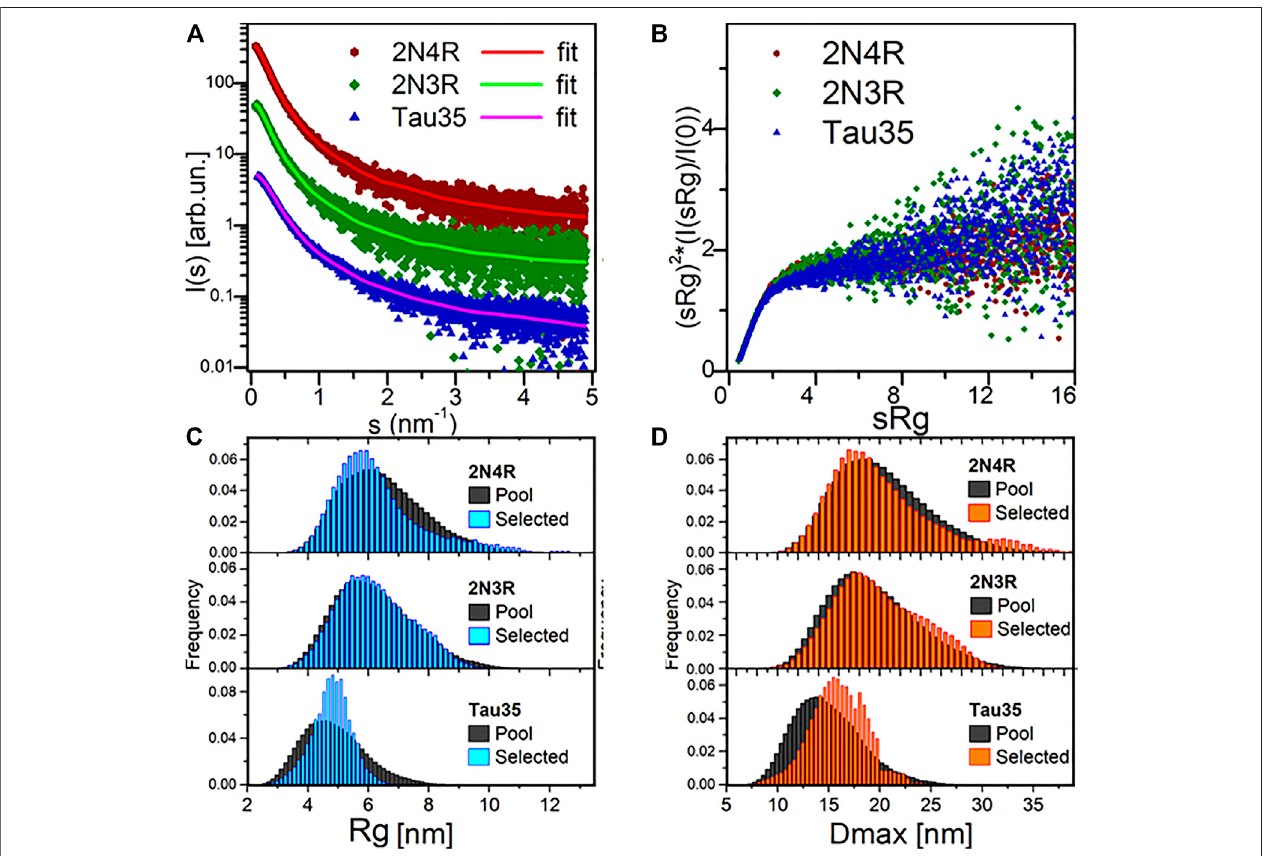
FIGURE 2 | SAXS analysis. (A) SAXS pro fi les from SEC-SAXS for 2N4R tau, 2N3R tau and Tau35 (symbols) and corresponding typical EOM fi t (solid lines, χ 2 in range 0.98 – 1.00). Plots vertically displaced relative to each other for clarity. (B) Dimensionless Kratky plots for the three proteins, showing a monotonous increase, indicativeoftheirunfoldednature. (C) Radiusofgyration(Rg)distributionsfortheselected2N4Rtau,2N3RtauandTau35ensemblescomparedtotherandompool. (D) Maximal intramolecular distance (Dmax) distributions for the selected 2N4R tau, 2N3R tau and Tau35 ensembles.